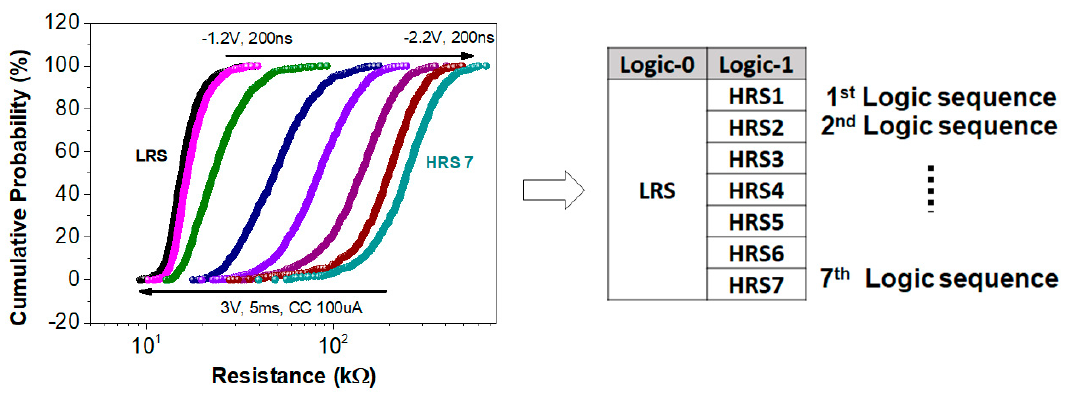
Figure 10. The coding scheme consisting of 7 different HRS states (one at a time) and 1 LRS state for the LUT generation. Attaining different reset conditions allows for the examination of memory window impact on the prediction error, also accounting for the higher resistance variability at deeper reset conditions.